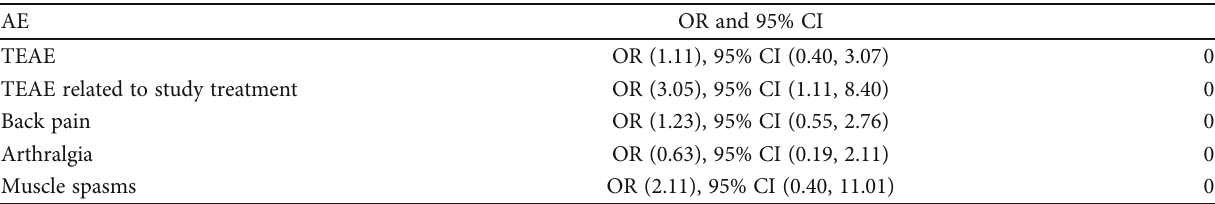
Table 3: Adverse event